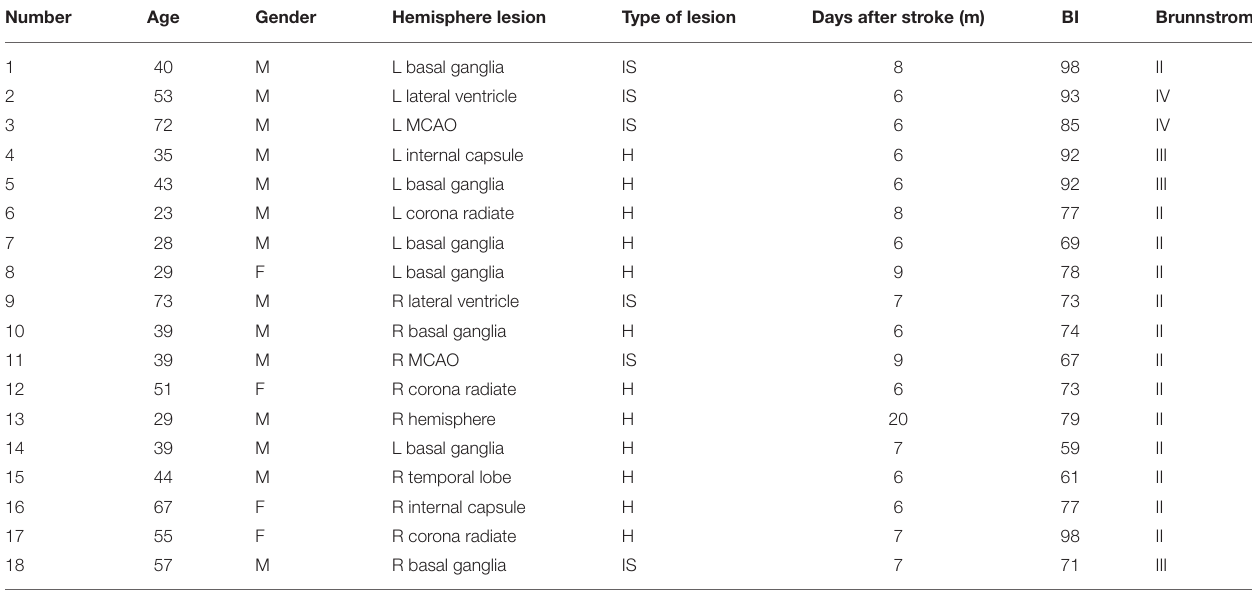
TABLE 1 | Demographic, clinical, and neuropsychological characteristics of the